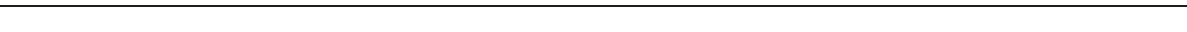
Fig. 5 UBR5 suppresses mutant HTT aggregation in HD-iPSCs. a Immunocytochemistry of control iPSC line #1 (Q21), control iPSC line #2 (Q33) and HD Q71-iPSC line #1 upon UBR5 knockdown. PolyQ-expanded and Hoechst 33342 staining were used as markers of aggregates and nuclei, respectively. Scale bar represents 10 μ m. The images are representative of four independent experiments. b Immunocytochemistry of Q180-iPSCs and two isogenic counterparts (i.e., HD-C#1 and HD-C#2), in which the 180 CAG expansion was corrected to a nonpathological repeat length. Scale bar represents 10 μ m. The images are representative of three independent experiments. c – g Filter trap analysis of the indicated control and HD-iPSC lines upon UBR5 knockdown with anti-polyQ-expansion diseases marker antibody. The images are representative of at least three independent experiments for each cell line. h Immunocytochemistry of HD Q71-iPSC line #2 upon knockdown of UBR5. PolyQ-expanded and Hoechst 33342 staining were used as markers of aggregates and nuclei, respectively. Scale bar represents 10 μ m. Proteasome inhibitor treatment: 5 µ M MG-132 for 12 h. The images are representative of four independent experiments. i Graph represents the percentage of polyQ aggregate-positive cells/total nuclei in HD Q71-iPSC line #2 (mean ± s.e.m., 3 independent experiments, 500 – 600 total cells per condition). Proteasome inhibitor treatment: 5 µ M MG-132 for 12 h. j Graph represents the percentage of polyQ aggregate-positive cells/total nuclei in HD Q180-iPSCs (mean ± s.e.m., 3 independent experiments, 300 – 400 total cells per condition). Proteasome inhibitor treatment: 5 µ M MG-132 for 12 h. k Filter trap analysis of the indicated control and HD-iPSC lines with anti-polyQ-expansion diseases marker antibody. Proteasome inhibitor treatment: 5 µ M MG-132 for 12 h. The images are representative of three independent experiments. l Filter trap analysis of HD Q180-iPSCs with anti-polyQ-expansion diseases marker antibody. Proteasome inhibitor treatment: 5 µ M MG-132 for 12 h. The images are representative of three independent experiments. All the statistical comparisons were made by Student ’ s t -test for unpaired samples. **** P <